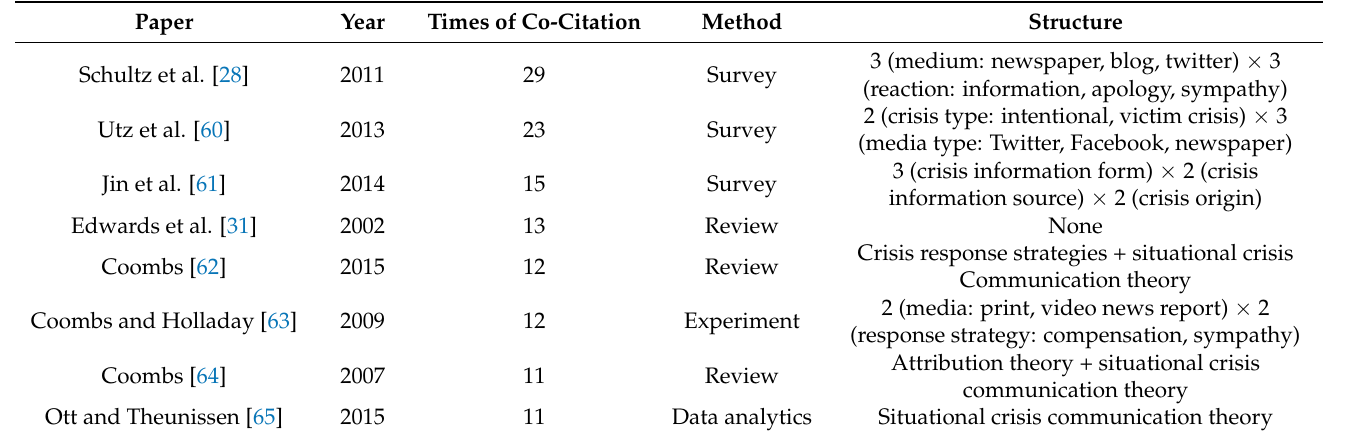
Table 8. Top eight co-cited journals for crisis and risk communication